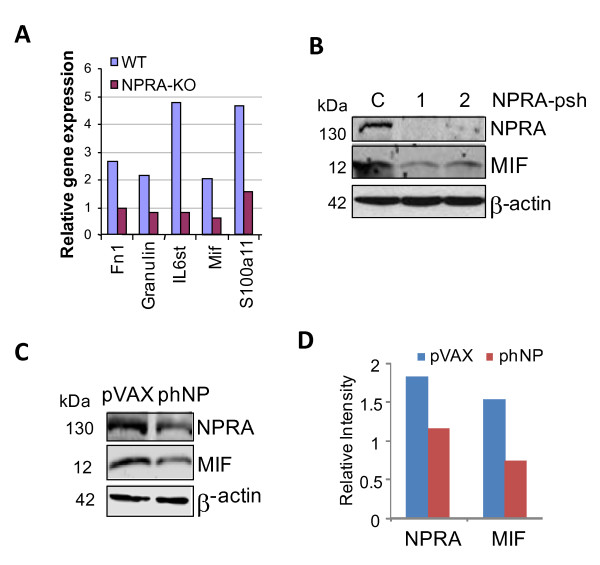
NPRA depletion inhibits MIF expression. (A) SuperArray analysis of prostate tissues of NPRA-KO and WT C57BL/6 mice. The relative expression level of genes that are altered in the prostate tissues of NPRA-KO vs. WT is shown. (B-C) Cells were transfected with iNPRAs. Whole cell lysates were extracted 72 hrs after transfection and examined for NPRA and MIF by western blotting. TRAMP-C1 cells were transfected with pshNPRAs or empty vector (B); PC3 cells were transfected with phNP73-102 plasmid or pVAX plasmid (C). (D) Relative band intensity for NPRA and MIF expression in Fig. 4C is shown.